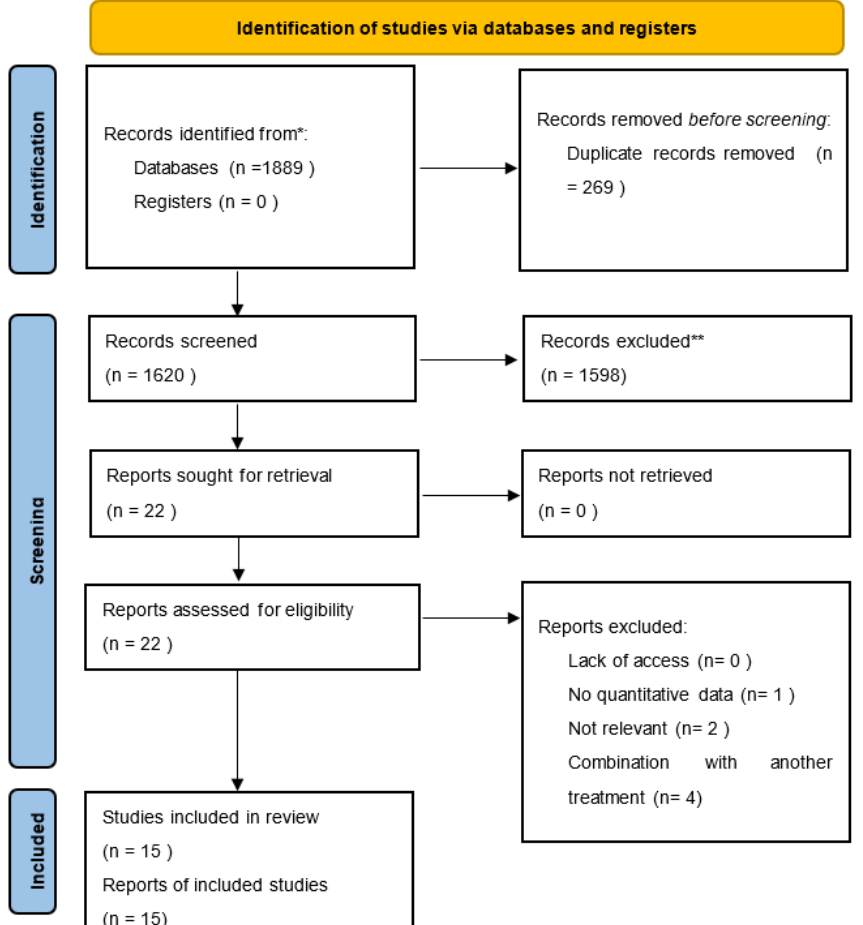
Figure 1. PRISMA flowchart of selected studies .